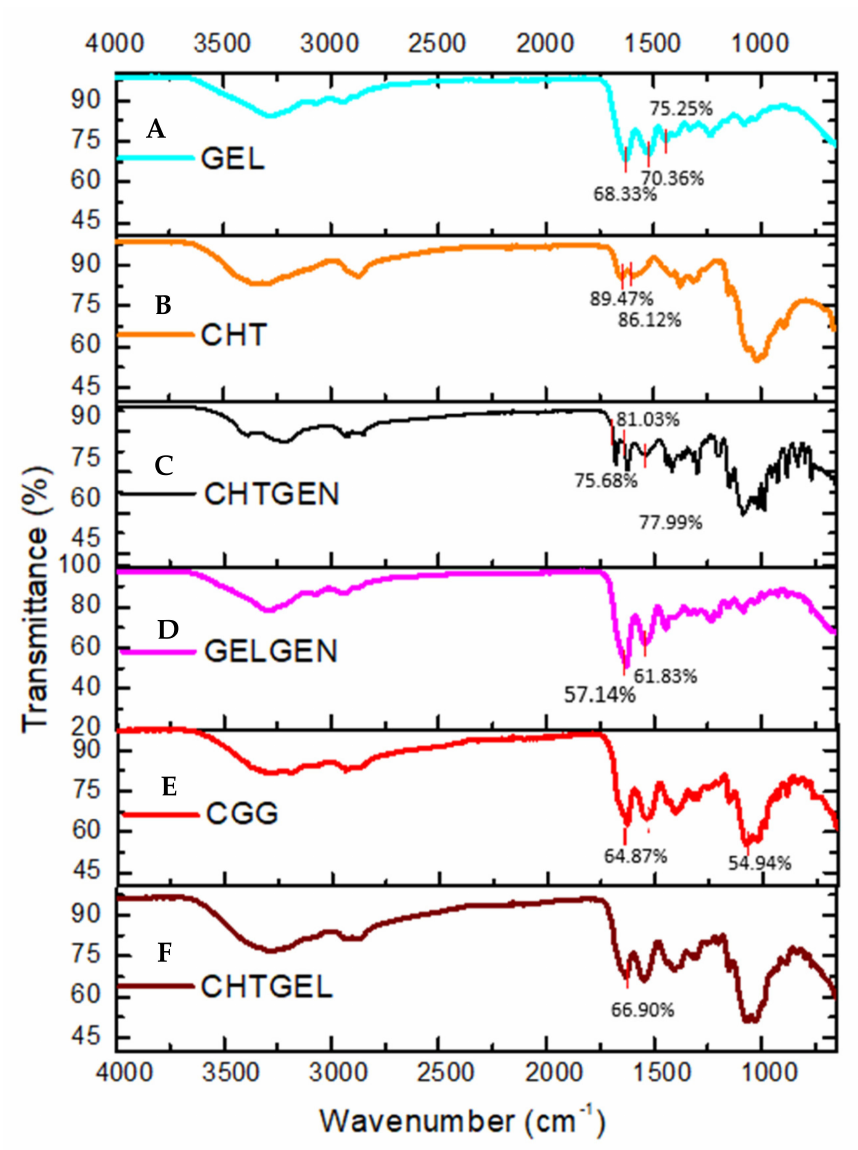
Figure 2. FTIR spectra of ( A ) pristine gelatin (GEL), ( B ) pristine chitosan (CHT), ( C ) chitosan-genipin (CHTGEN), ( D ) gelatin-genipin (GELGEN), ( E ) chitosan-gelatin-genipin (CGG) and ( F ) chitosan- gelatin